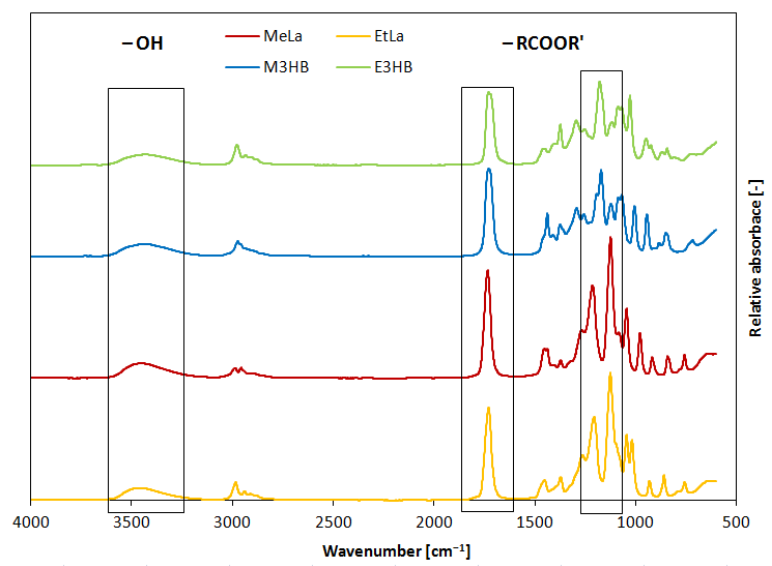
Figure 4. FT-IR spectra of the synthesized alkyl esters as products of the depolymerization reaction